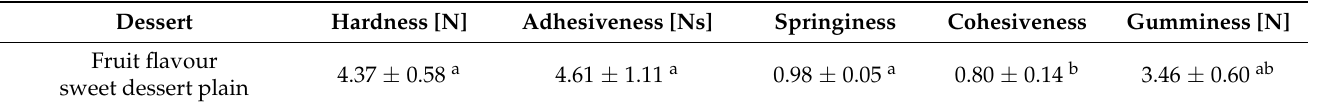
Table 2. Texture profile analyses of ready-to eat-desserts made with the starches studied.